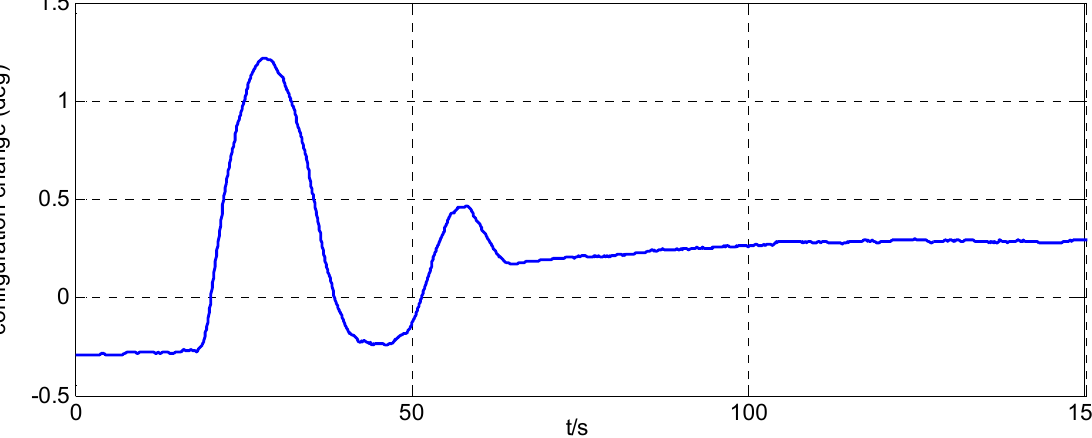
Figure 12. Relative angle error inside the simulator when θ z ( 0 ) = 1.7 ◦ .